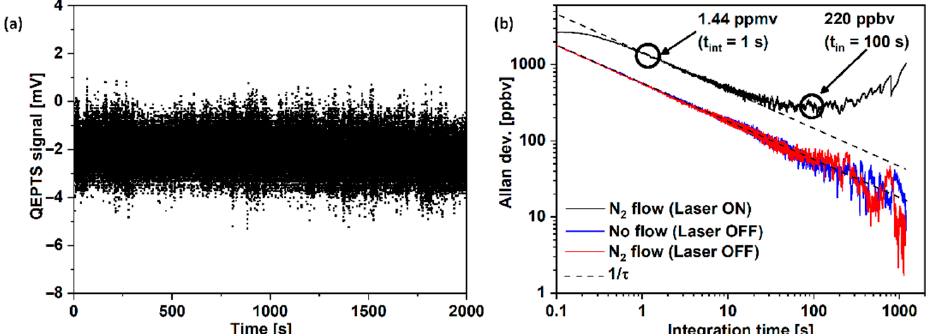
Figure 8. ( a ) Noise amplitude registered with N 2 flowing through the sensor. ( b ) Allan deviation plot calculated from noise registered with N 2 flowing through the sensor (black trace), with N 2 flowing through the sensor but with the laser turned off (red trace), and without the flow of N 2 (blue trace).